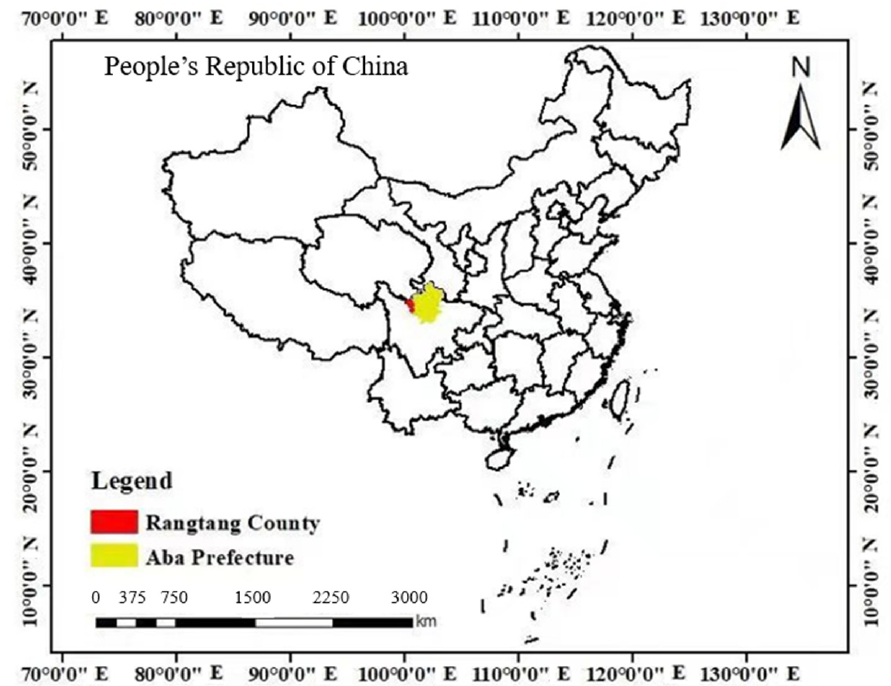
Figure 1. Location of the Study area, Rangtang County, Aba Prefecture, People’s Republic of China.